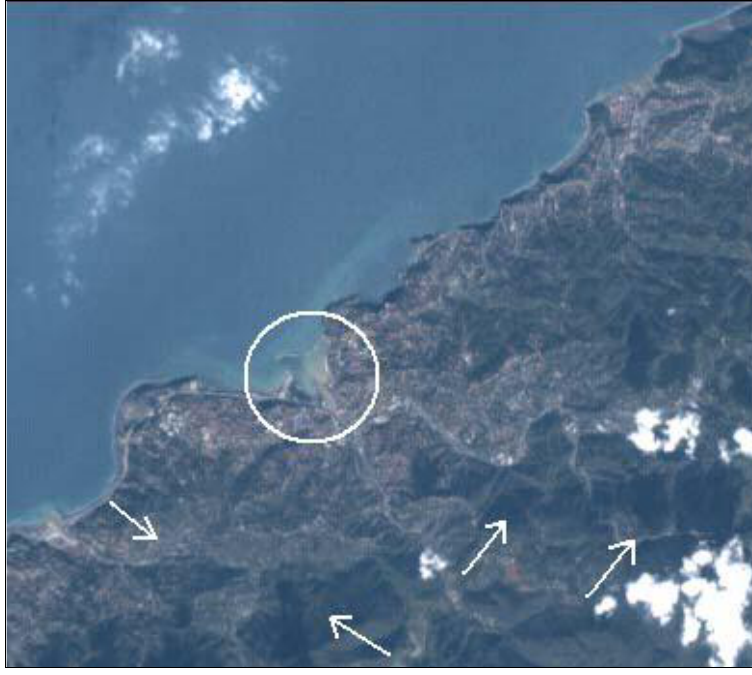
Figure 1. IKONOS images of Zonguldak test area which is taken 2002.